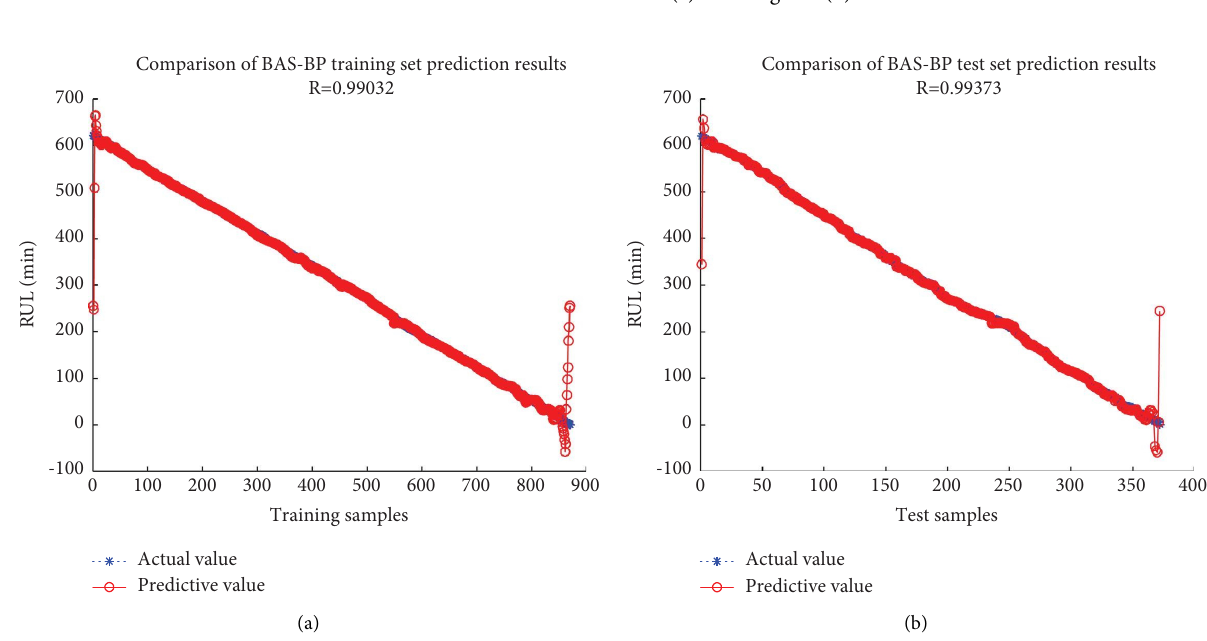
Figure 10: Prediction results of GA-BP. (a) Training set. (b) Test set.